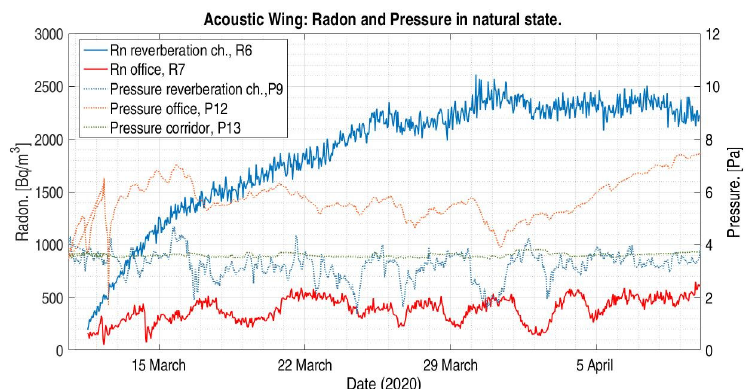
Figure 12. Radon and pressure levels in the acoustic wing. Pressure reference was established on the floor of the shed near the reverberation chamber.